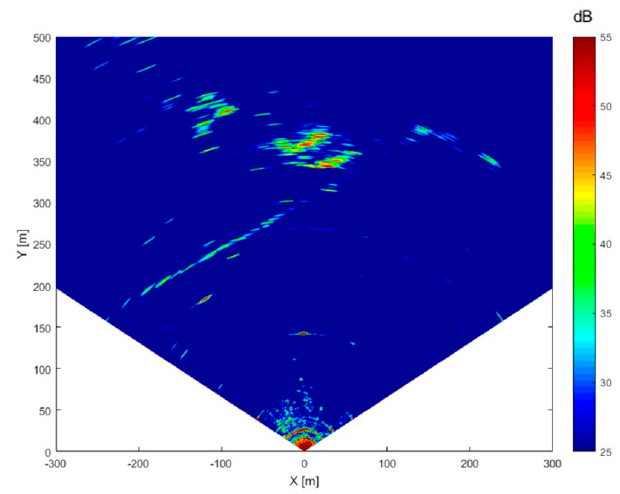
Figure 12. SPARX SNR estimated map (in dB).